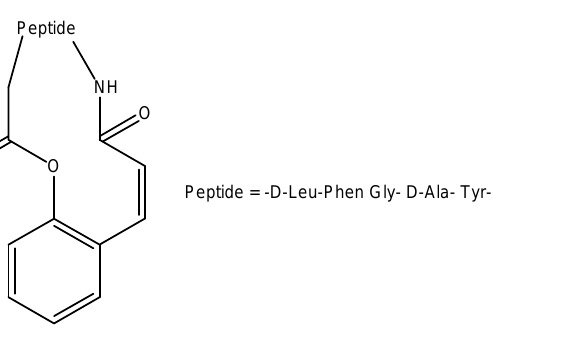
Figure 3 . Coumarin system applied to